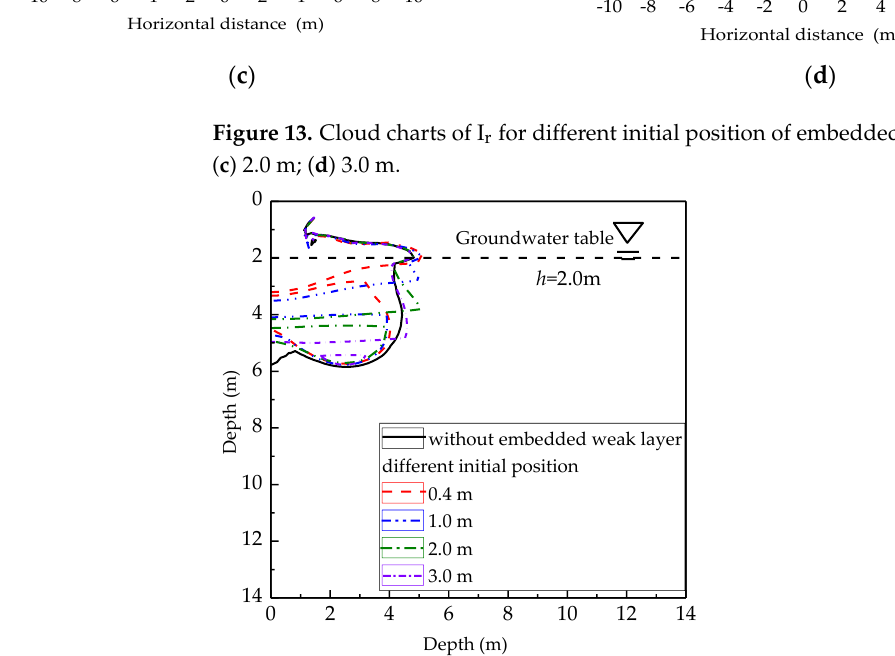
Figure 14. Cloud lines of I r = 7.7% for different initial position of soft interlayers.